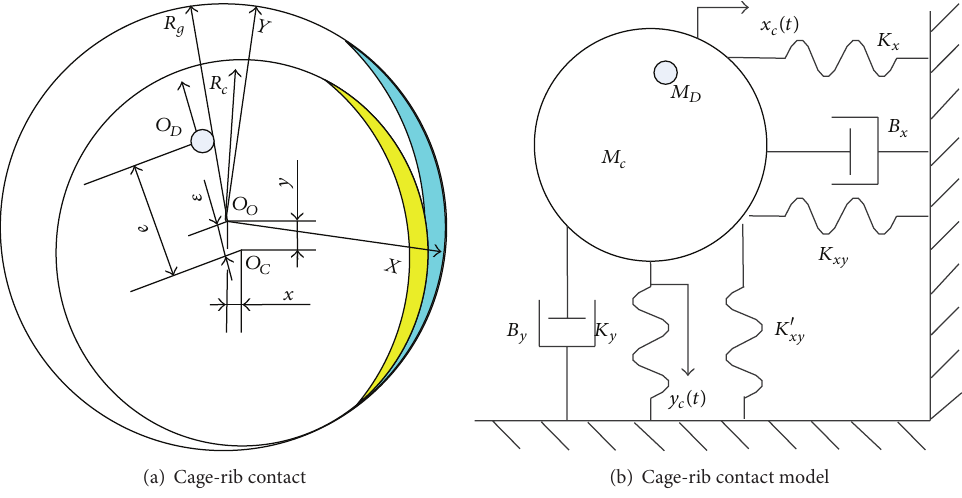
Figure 6: 2-DOF model of cage/rib